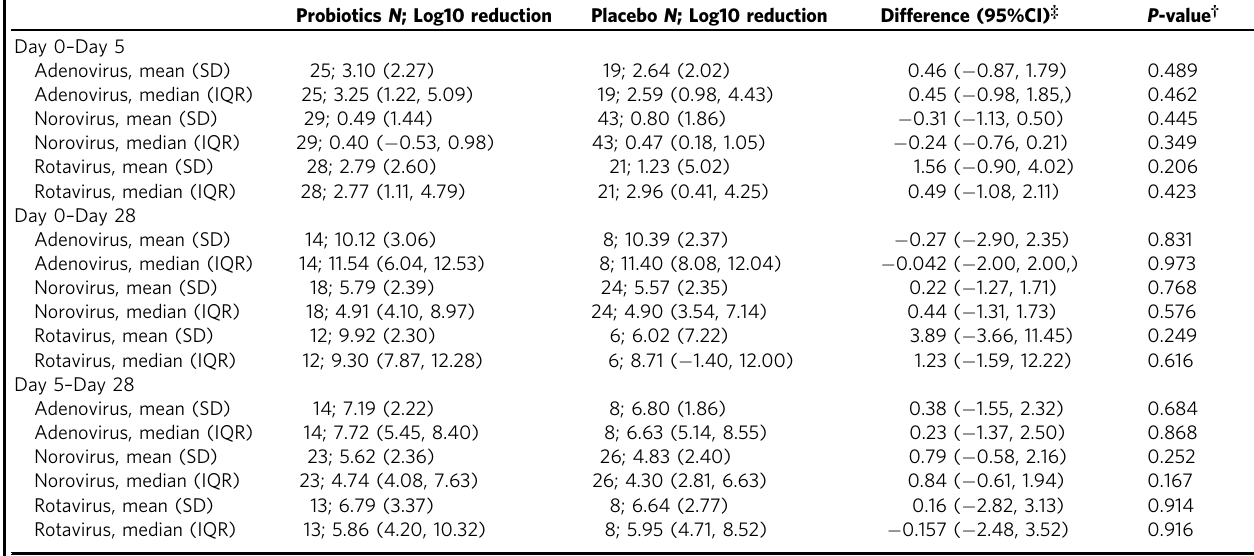
Table 3 Stool pathogen reduction, follow-up stool specimens, probiotic versus placebo, log10 transformed copies/gm stool*.